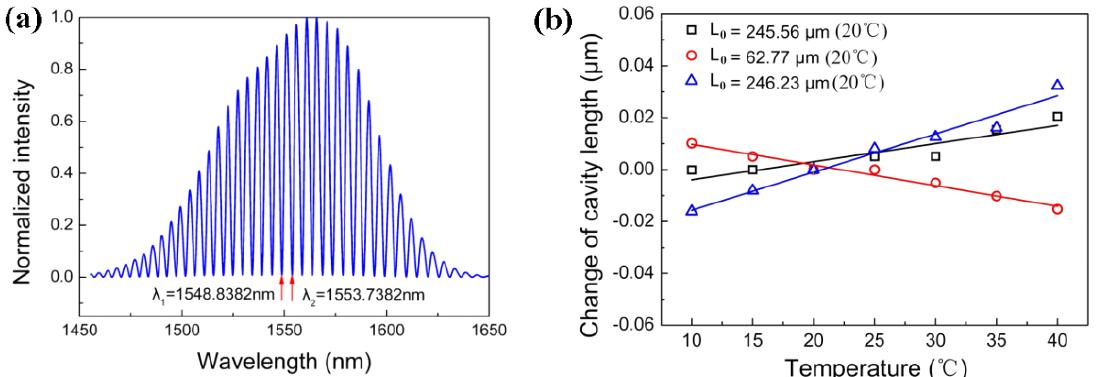
Figure 5. ( a ) Spectral interference pattern of the FPI based fiber-optic microphone measured at 20 °C; ( b ) changes of the FP cavity lengths of the microphone versus ambient temperatures for L 0 = 245.66, 62.77, and 246.23 μ m, respectively.